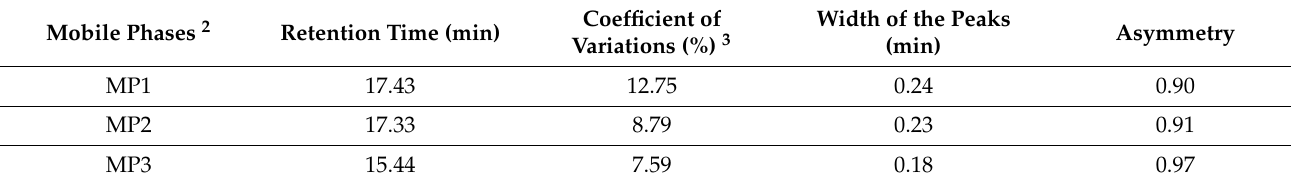
Table 2. Results from the evaluation of three mobile phases (MP1–3) for detecting ergosterol (10 µ g/mL) with Gradient 10 (0–5 min 10% B 1 , 5–8 min linear increase from 10% to 100% B, 8–12 min 100% B, and 12–22 min linear decrease from 100% to 10% B).